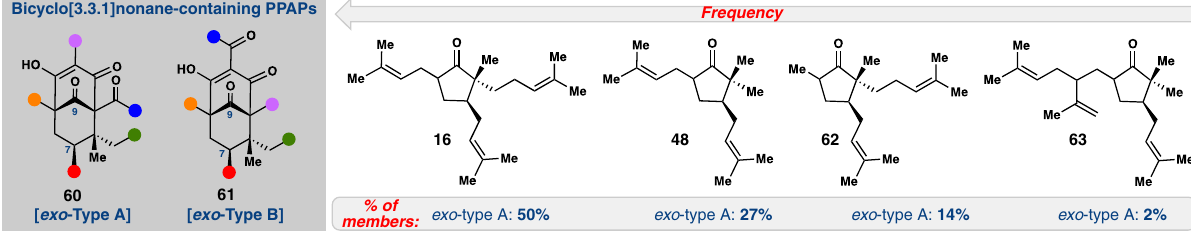
Fig. 6 Building block analysis of bicyclo[3.3.1]nonane-containing exo -type A PPAPs. Four simple building blocks are embedded in over 90% of members using